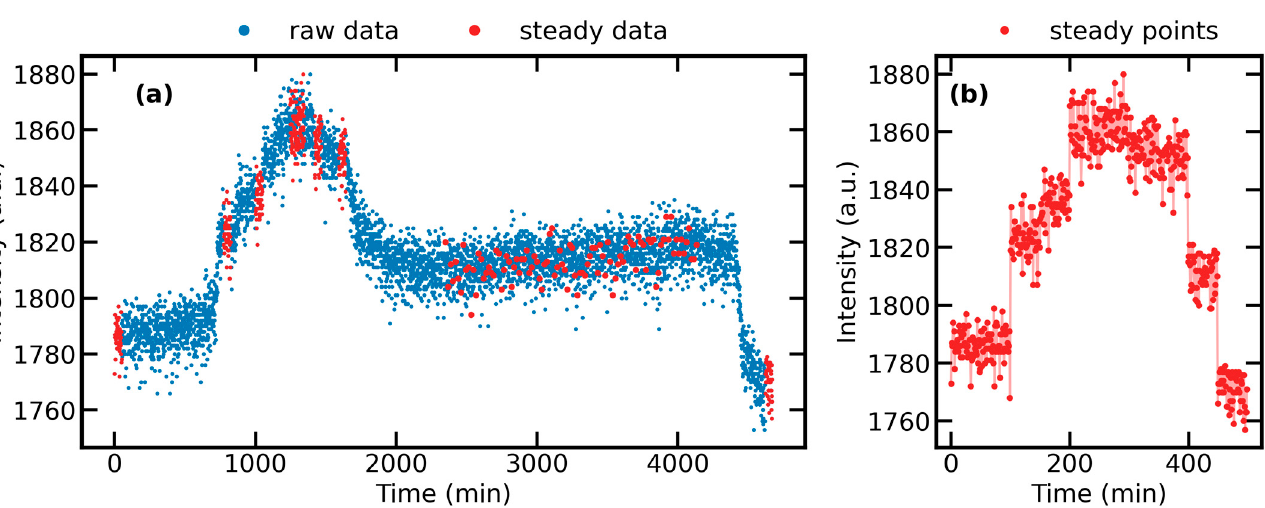
Figure A1. ( a ) Raw reflected light intensities for different RH between 75% and 100%, achieved by integrating between the wavelengths of 388 and 400 nm ( b ) chosen stable points for analysis. Raw data from the reflected light intensity used for the characterization of cement paste through sorption isotherm, as seen in Figure 6, is presented in Figure A2.